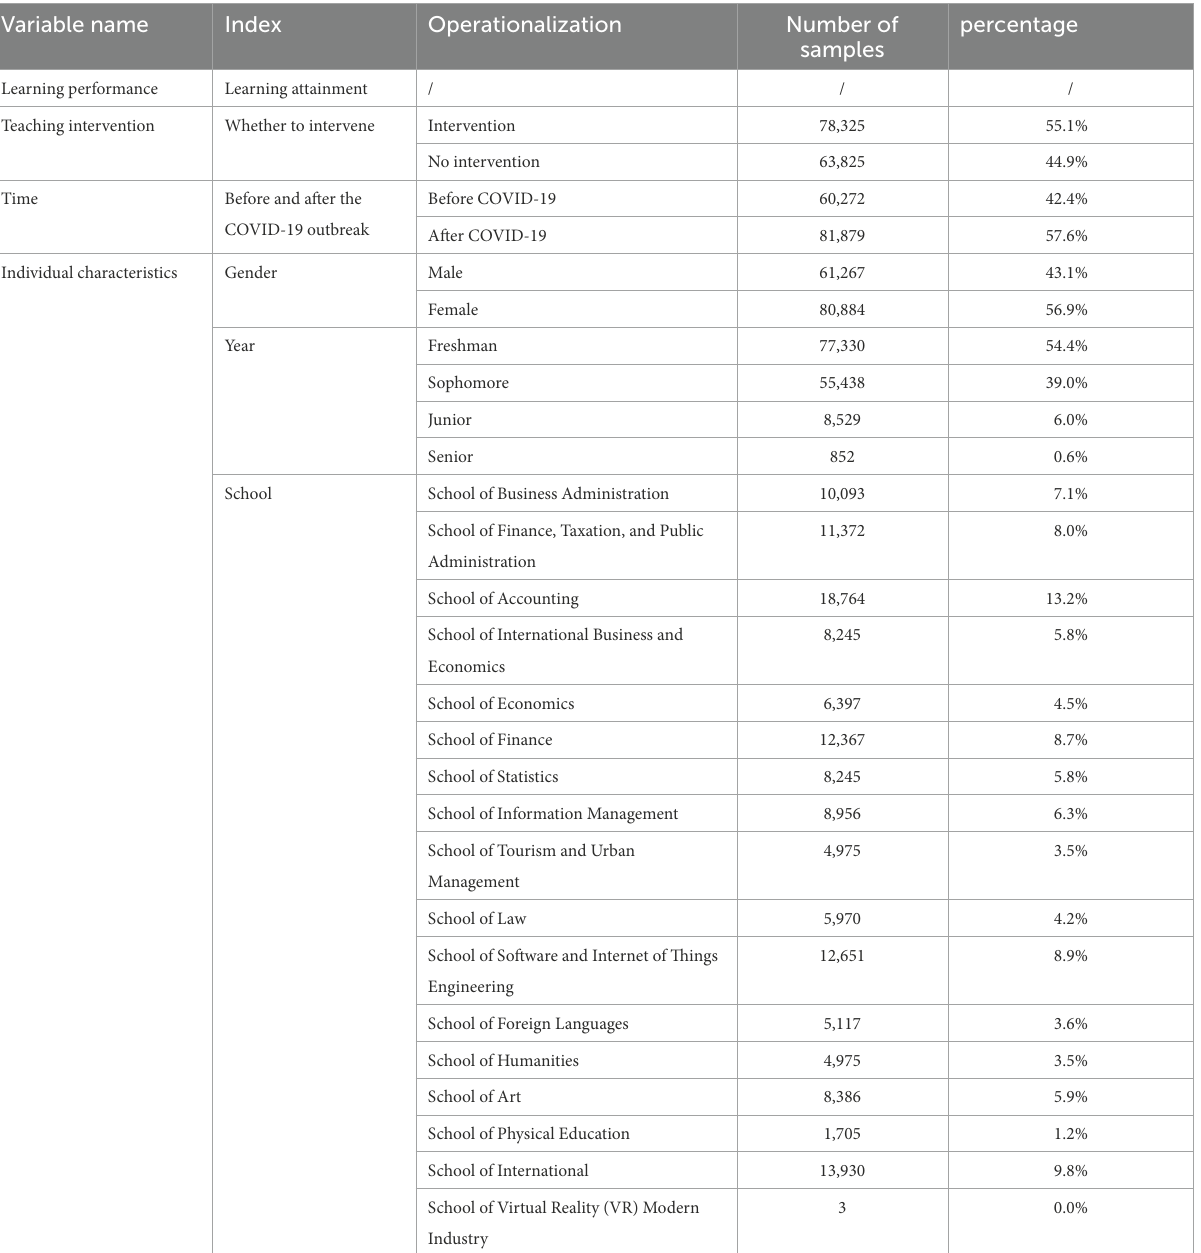
TABLE 2 Demographic characteristics of respondents ( n =